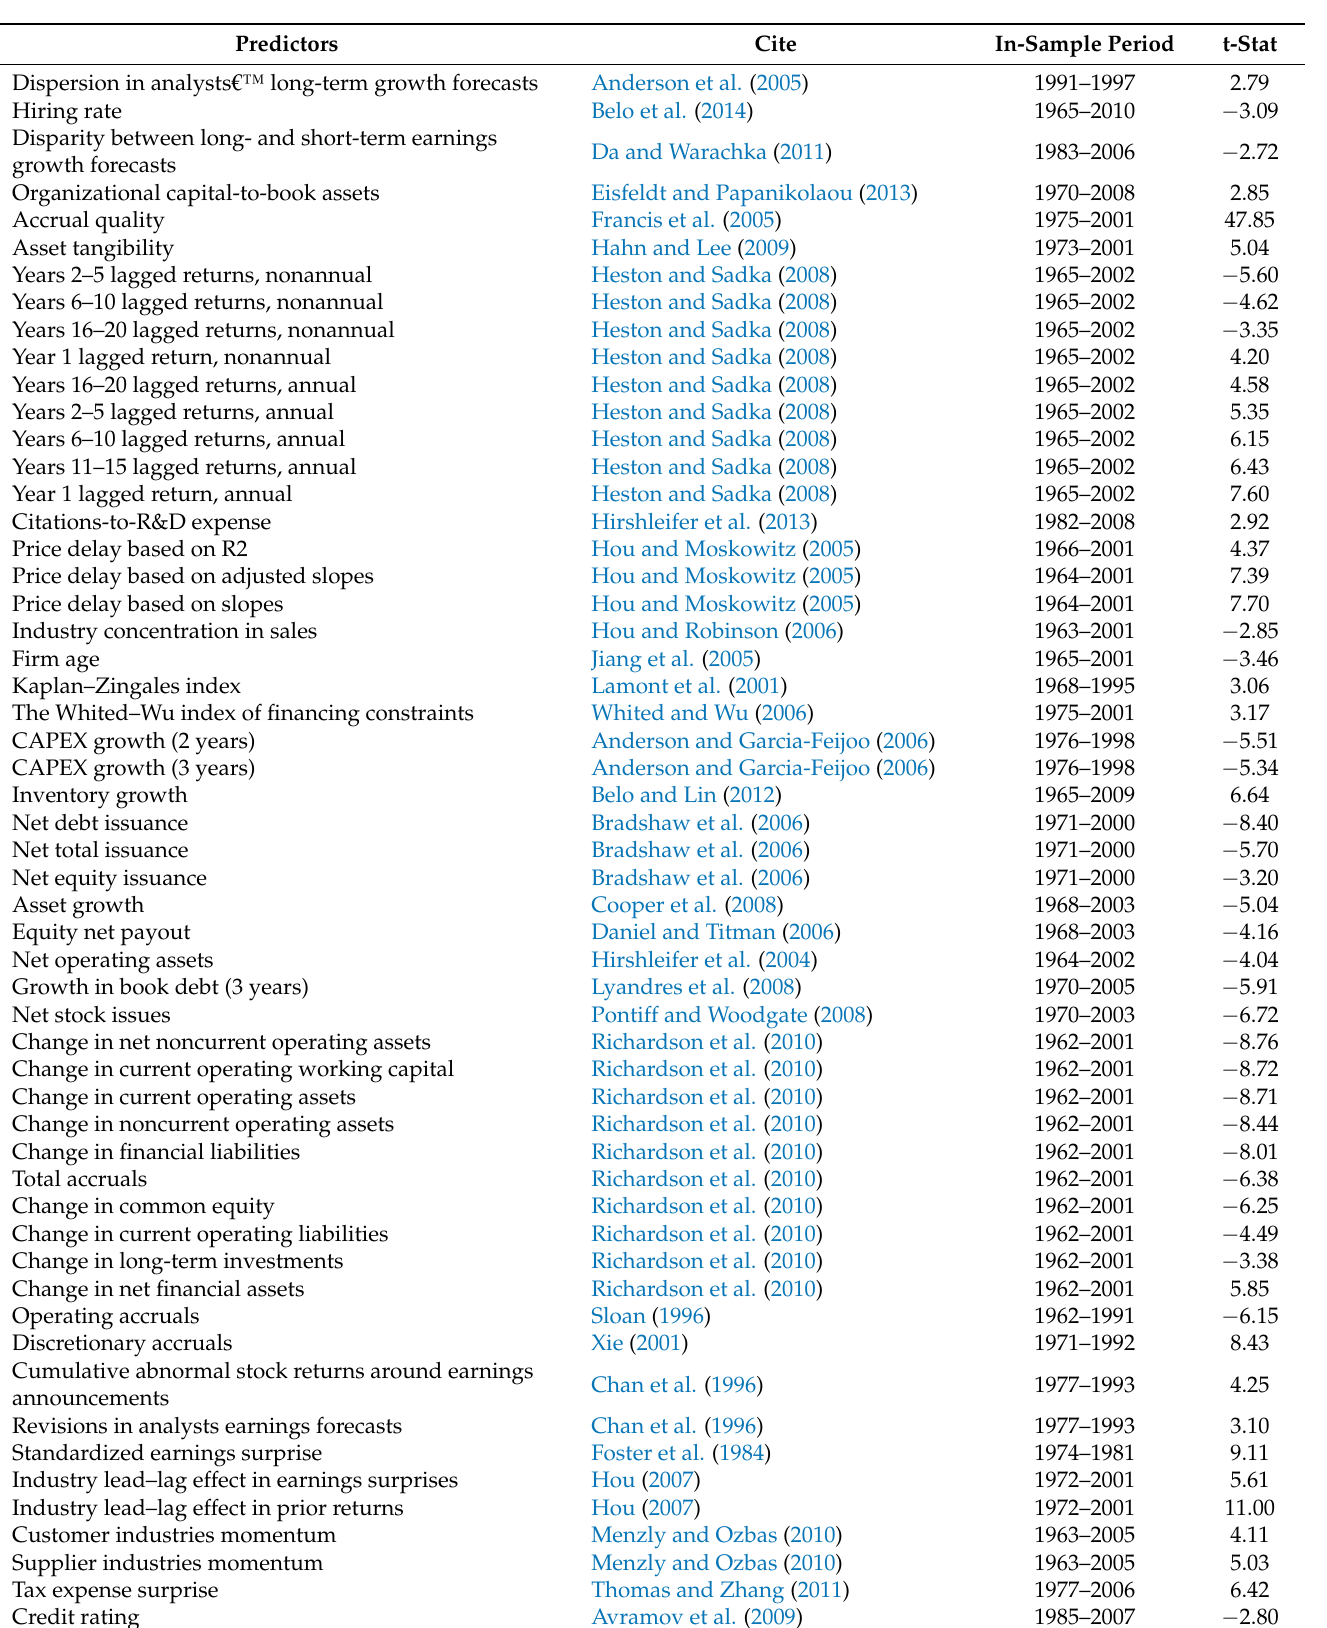
Table 1. Summary of